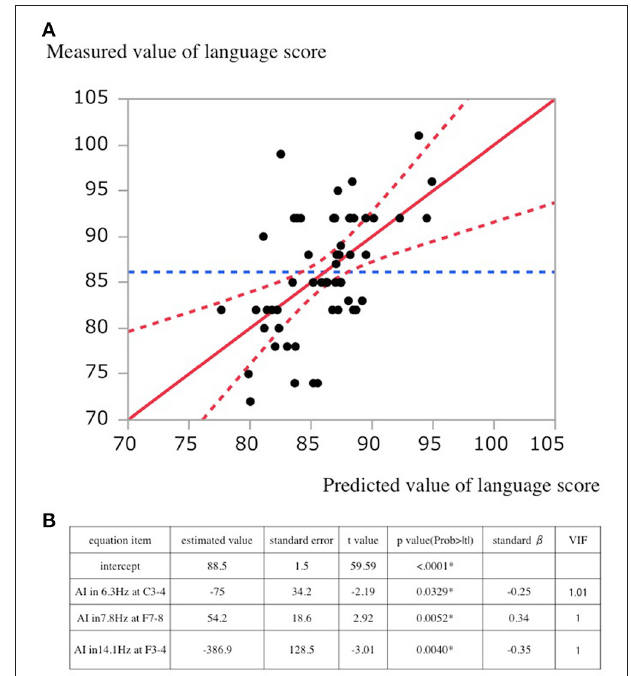
FIGURE 4 | (A) A scatterplot of predicted and actual values. The solid lines indicate the regression line. Dashed lines indicate the 95% confidential interval for the regression line. (B) Estimated values in the regression equation. standard β , standard partial regression coefficient; VIF, Variance Inflation